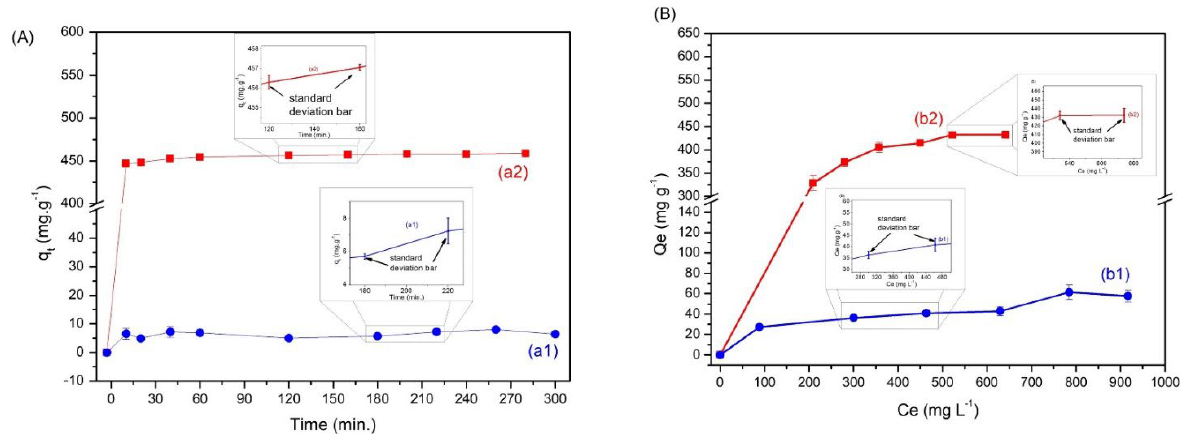
Figure 4. Adsorption kinetics for biochar (BE) (a1) and activated biochar (ABE) (a2) ( A ) and isotherm concentration for biochar (BE) (b1) and activated biochar (ABE) (b2) ( B ). Table 1. Adjustment to the kinetic model of pseudo-first-order and pseudo-second-order for the biochar (BE) and activated biochar (ABE).